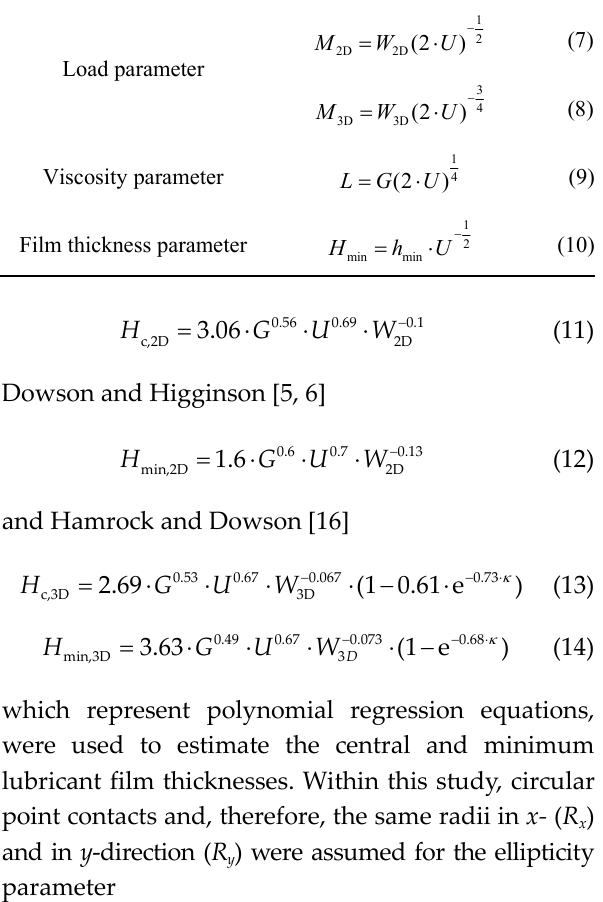
Table 2 Blok/Moes non-dimensional parameters according to Blok/Moes [7,